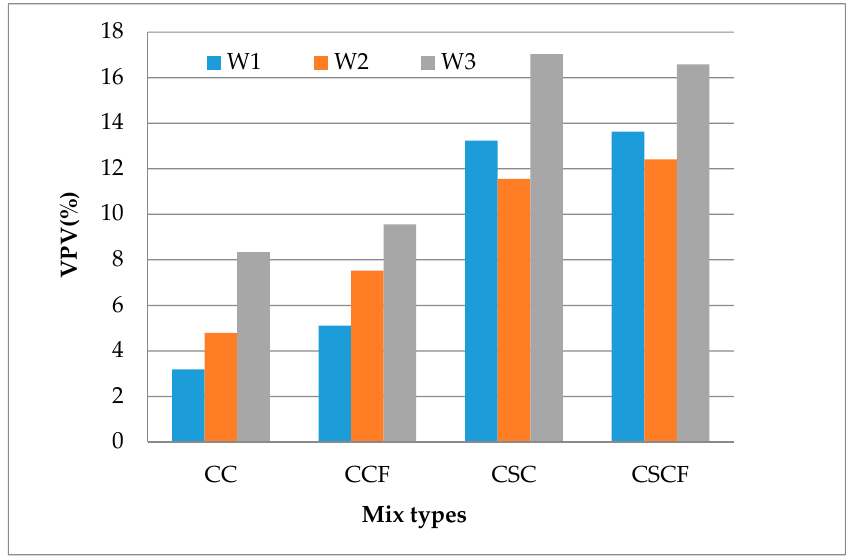
Figure 6. Results of VPV test.